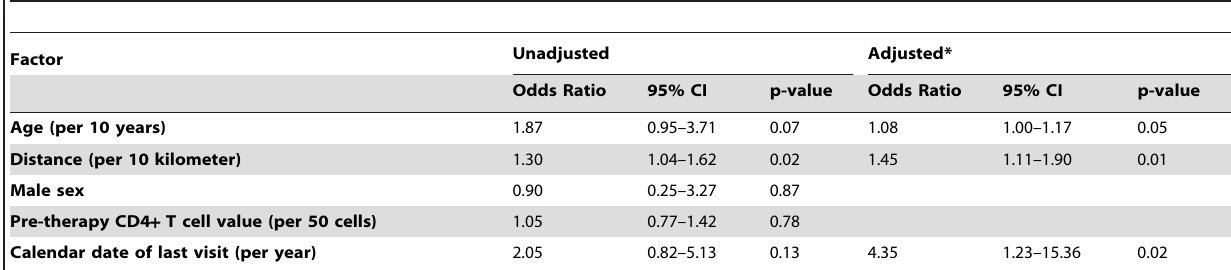
Table 3. Factors associated with retention in care among a sample of patients who were lost to follow-up from the ISS Clinic (N=